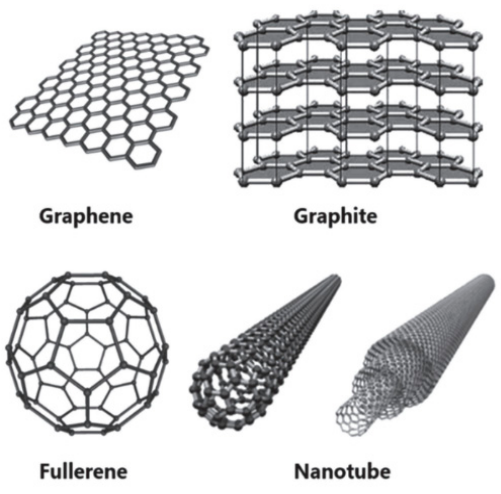
Figure 12. Structure of various carbon materials [127].